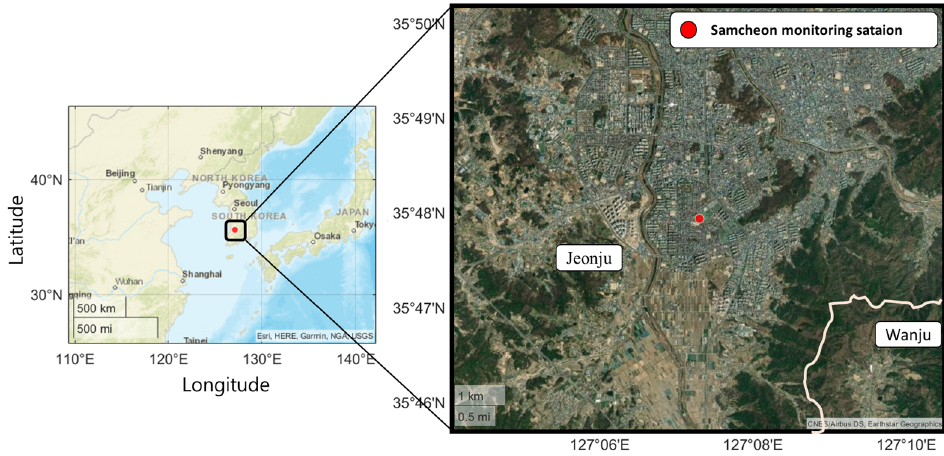
Figure 1. Map of the measurement site in Jeonju, South Korea (35°47 ′ 56.4’’ N, 127°7 ′ 19.2’’ E).